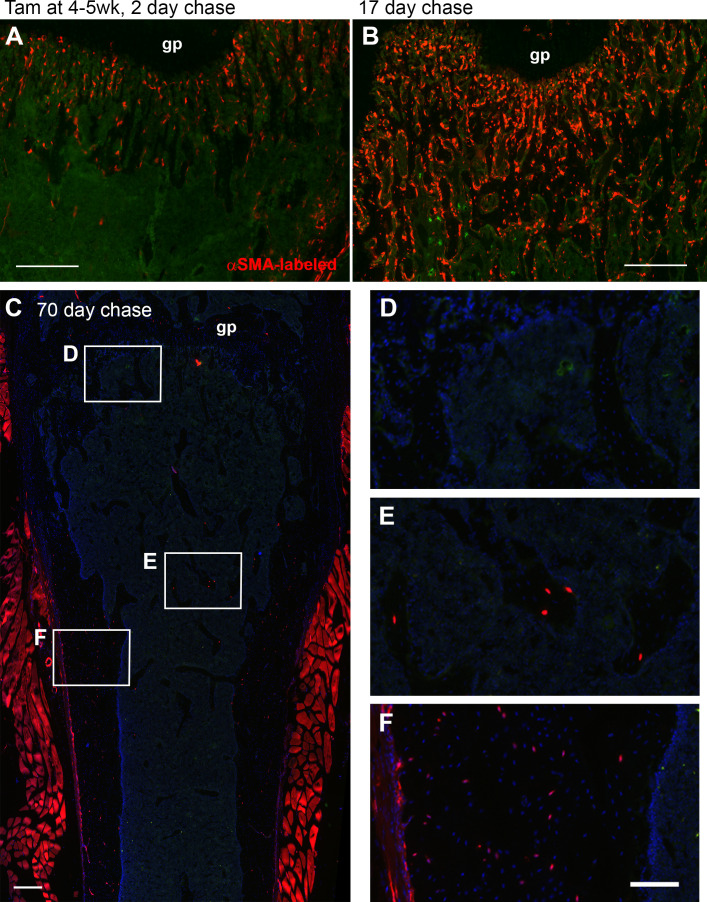
Alpha smooth muscle actin (αSMA) lineage tracing in the bone marrow compartment of juvenile mice.Lineage tracing in the distal femur of αSMACreER/Ai9 mice at different time points after tamoxifen treatment at 4–5 weeks of age. (A) and (B) are replicates of data shown in Grcevic et al., 2012. Both show background signal in bone marrow in green and (C–F) have DAPI staining in blue. After 17 days, many osteoblasts and osteocytes in trabeculae are labeled, but at day 70 magnified areas show that few labeled cells are present in the primary spongiosa (D), but labeled osteocytes are retained in more proximal trabeculae (E) and in some cortical regions (F). Muscle is labeled due to targeting of some satellite cells by αSMACreER (Matthews et al., 2016). Scale bars are 250 µm (A–C) and 100 µm (D–F). gp, growth plate.